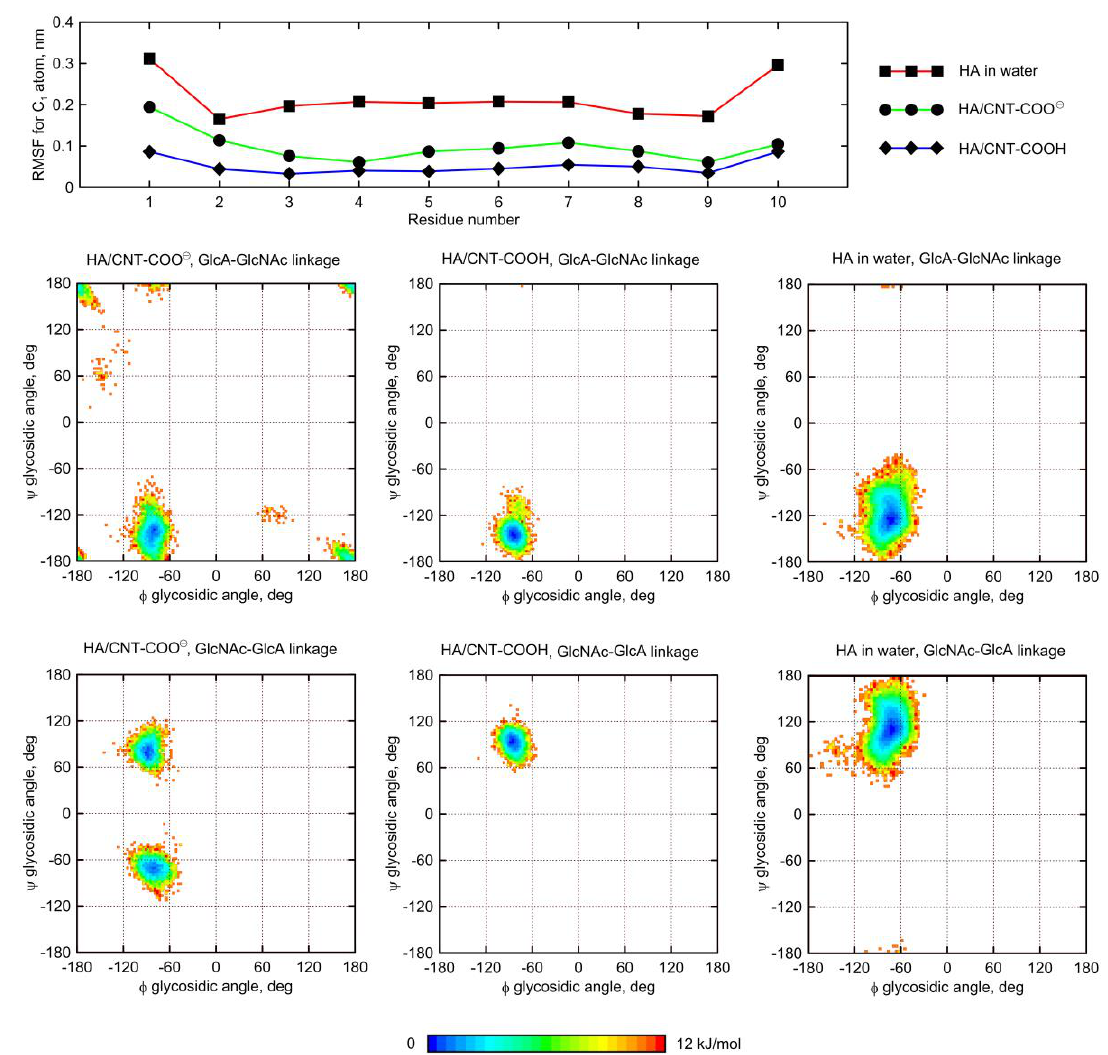
Figure 8. (top) Root-mean-square-fluctuation (RMSF) parameter values calculated for anomeric carbon atoms in the HA decamer. (bottom) Free energy maps calculated from unbiased MD trajectories in the glycosidic dihedral angle ϕ, ψ coordinates for the HA molecule. Free energy values were determined by using the Boltzmann inversion method. The calculations included both types of glycosidic linkages present in the oligosaccharide decamer and the two possible states of the glycan molecules, i.e., either free in water (HA in water in the legend) or adsorbed on the fCNT (HA/CNT-COOH and HA/CNT-COO ⊖ in the legend) surface. The energy scale is in [kJ/mol].